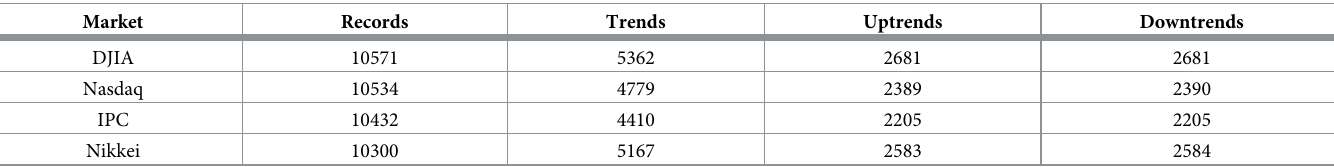
Table 1. Numbers of total observed records and respective uninterrupted trends for all data samples of financial indices studied. The data have been filtered, e.g. by removing null